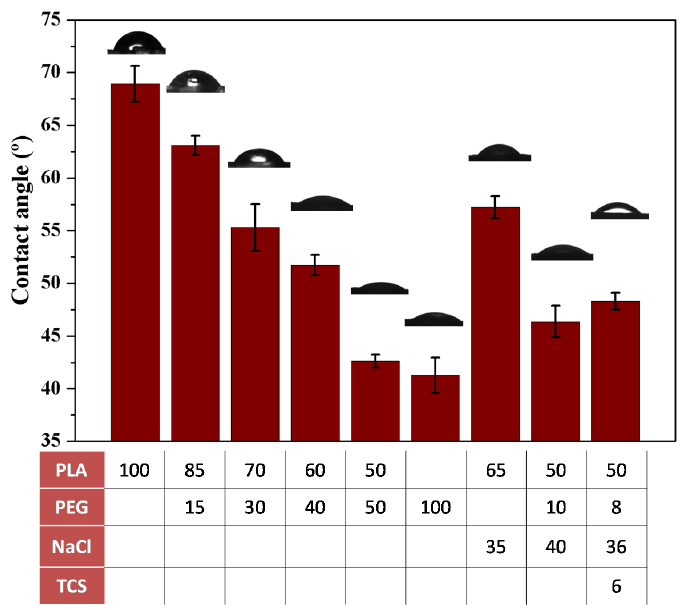
Figure 12. Contact angle for representative micromolded specimens. On the bars are shown the images of the water droplets on the respective material whose composition is shown in the table below.